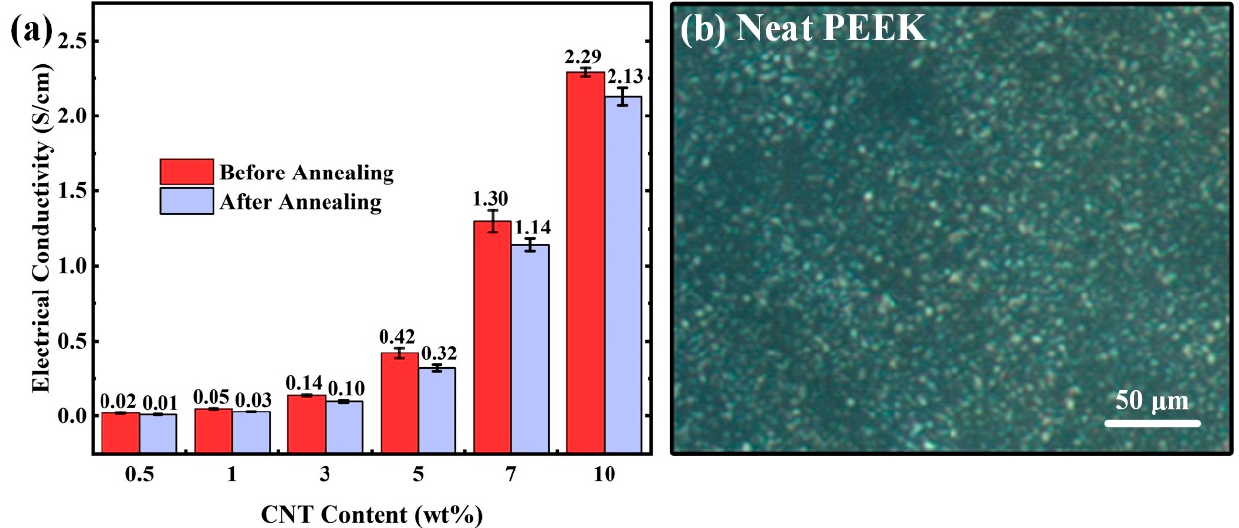
Figure 9. ( a ) Electrical conductivity of PEEK/CNTs composites with different CNTs content; ( b ) Polarizing optical microscope image for neat PEEK.